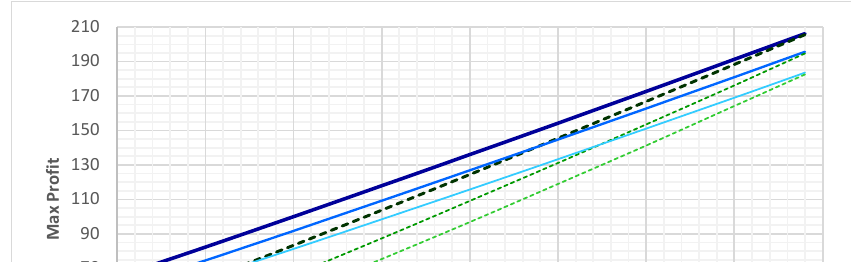
Fig. 4. Optimal purchasing quantity